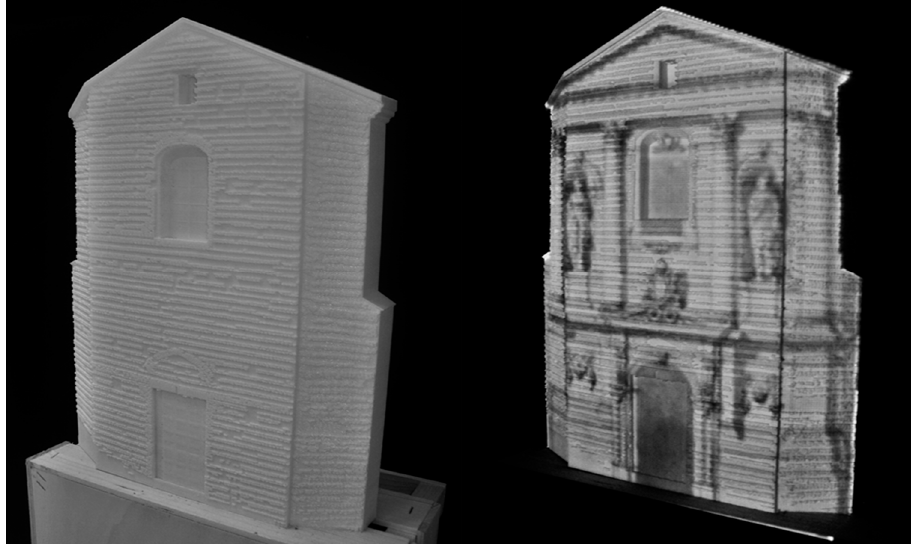
Figure 8. Results of video projecting test, over PLA model. As shown by figure the process of digital warping of the original content has been moderate successful, reapplying almost completely, by deformation, an image over a non-coplanar surface. At the same time, the test demonstrated that the promotion of a Cultural Asset needs high-definition projectors and ad hoc content, in order to return an acceptable level of image